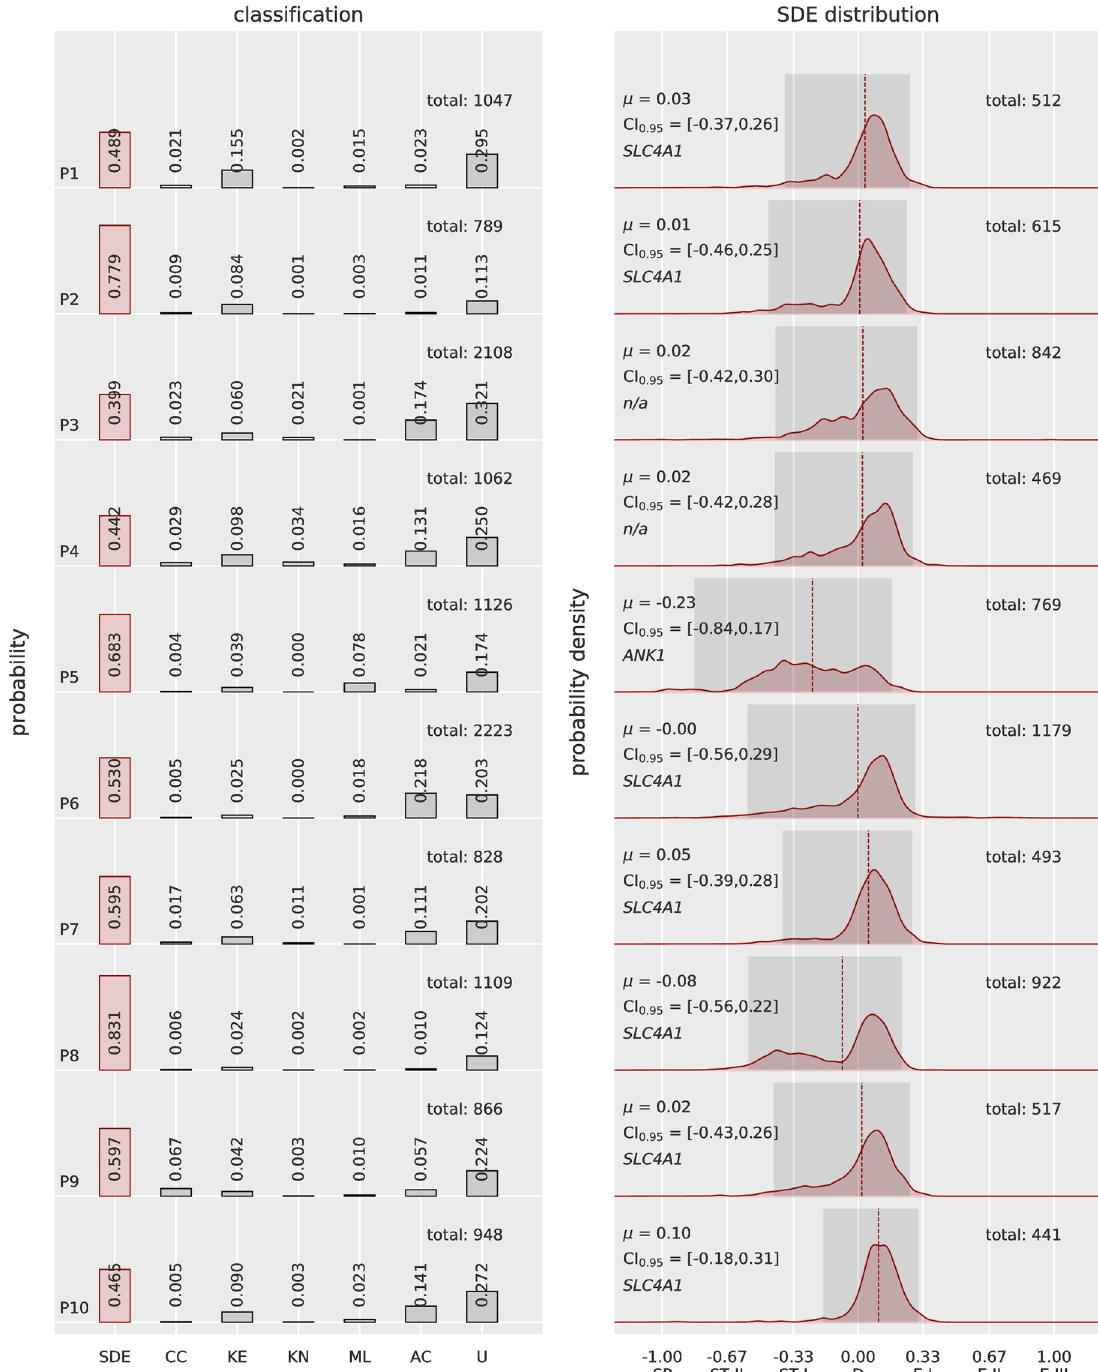
Fig 5. Automatic 3D RBC shape recognition for patients affected by hereditary spherocytosis. The total number of analyzed cells per patient is indicated on top right of the classification bar graph. The probability density distributions within the SDE range show the expected value μ (dashed red line) and highlight 95% confidence intervals (dark gray area). The results demonstrate that most of the patients have expected values related to discocytes, with a tendency toward stomatocytes. A population of spherocytes (score − 1) is lacking in all 10 samples, proving that such a shape is not a hallmark of the disease. Additionally, shape profiles among patients are different, suggesting a relation to the various genetic mutations ( SLC4A1 , and in one case ANK1 ). In particular, P1 and P2 as well as P3 and P4 (nonidentified mutation) are relatives and show similar profiles, especially within the SDE range. P5 harbors a mutation that affects the cytoskeletal protein ankyrin, resulting in the highest number of stomatocytes, including some spherocytes. P6, P7 and P9 are affected